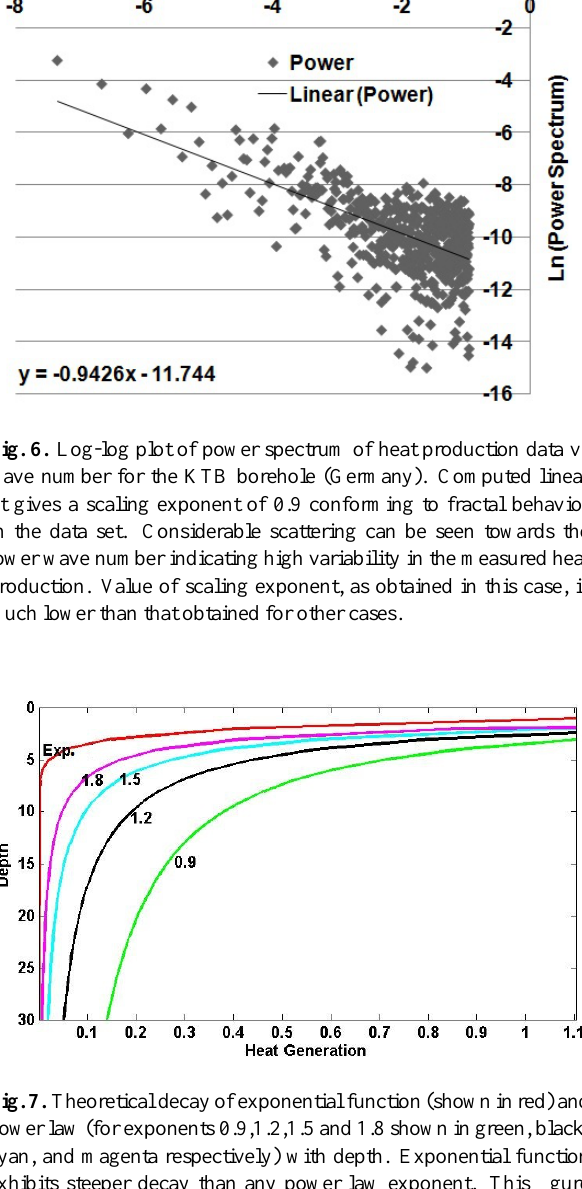
Table 3. Measured and computed heat production using exponential model (Eq. 1) with depth in Vredefort granitic basement, (Kaapvaal craton), South